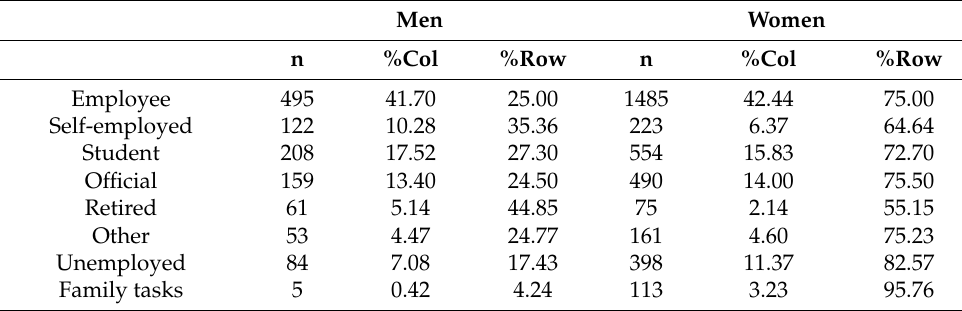
Table 3. Relationship between employment status and gender.